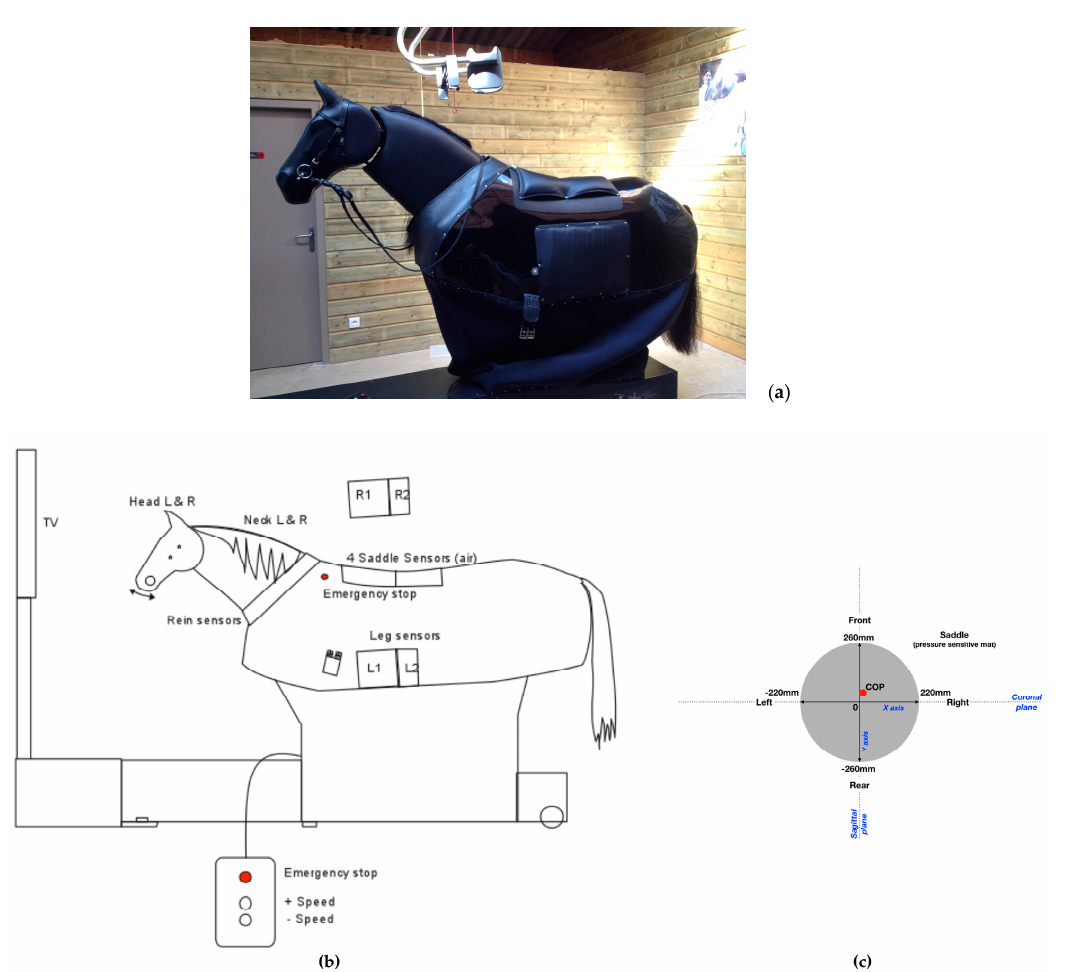
Figure 1. ( a ) Photograph of the equine simulator; ( b ) Diagram of the equine simulator used in the hippotherapeutic treatment; ( c ) Diagram of the pressure sensitive saddle and the analyzed biomechanical variables.